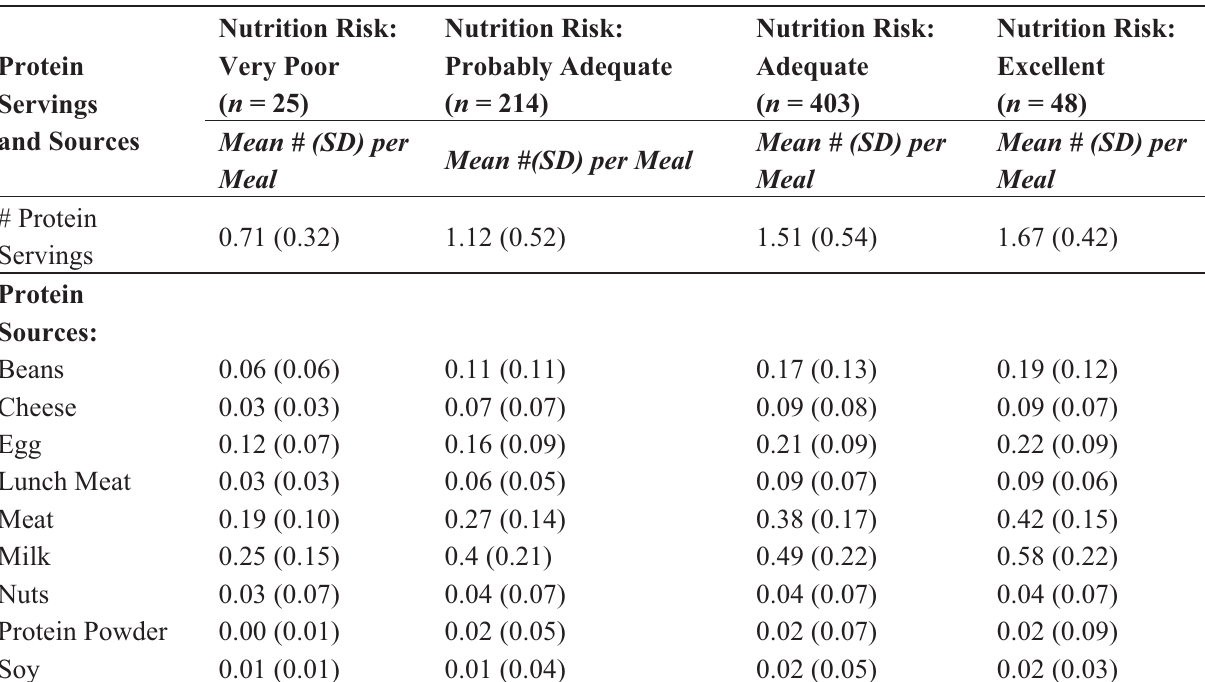
Table 3. Mean #, SD, and Sources of Protein Servings Grouped According to Braden Nutrition Subscale Risk Categories ( n =